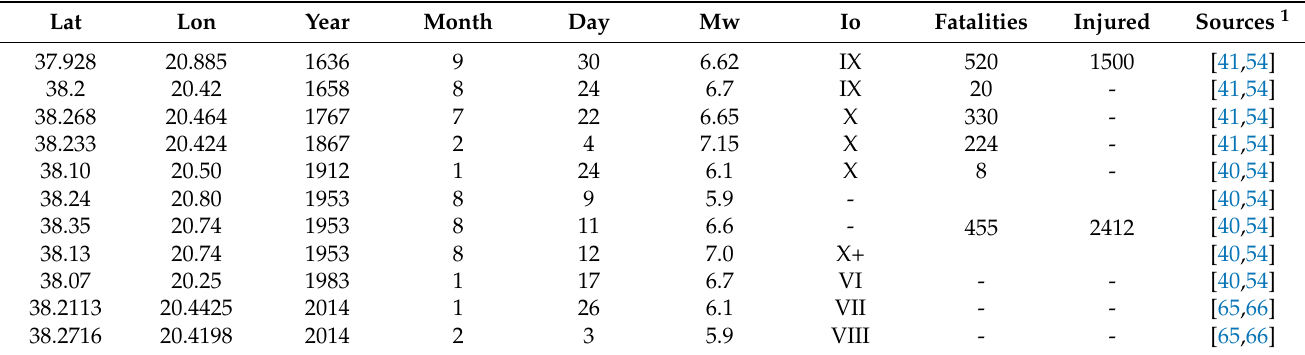
Table 2. Focal parameters and impact on the local population of the studied earthquakes that triggered landslides in Cephalonia